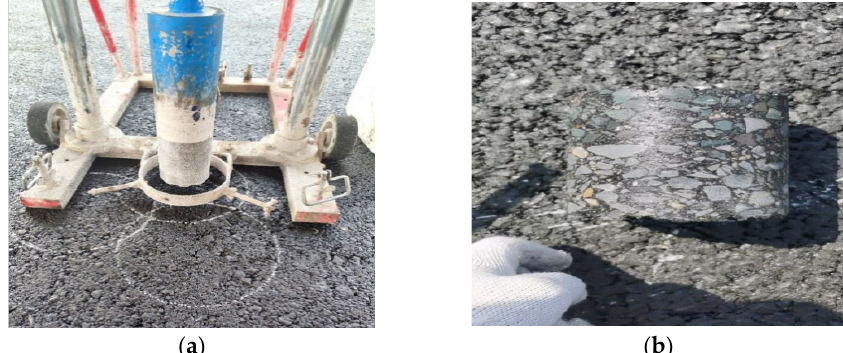
Figure 4. Drilling core ‐ sample at the calibration point: ( a ) drilling process; ( b ) core sample.